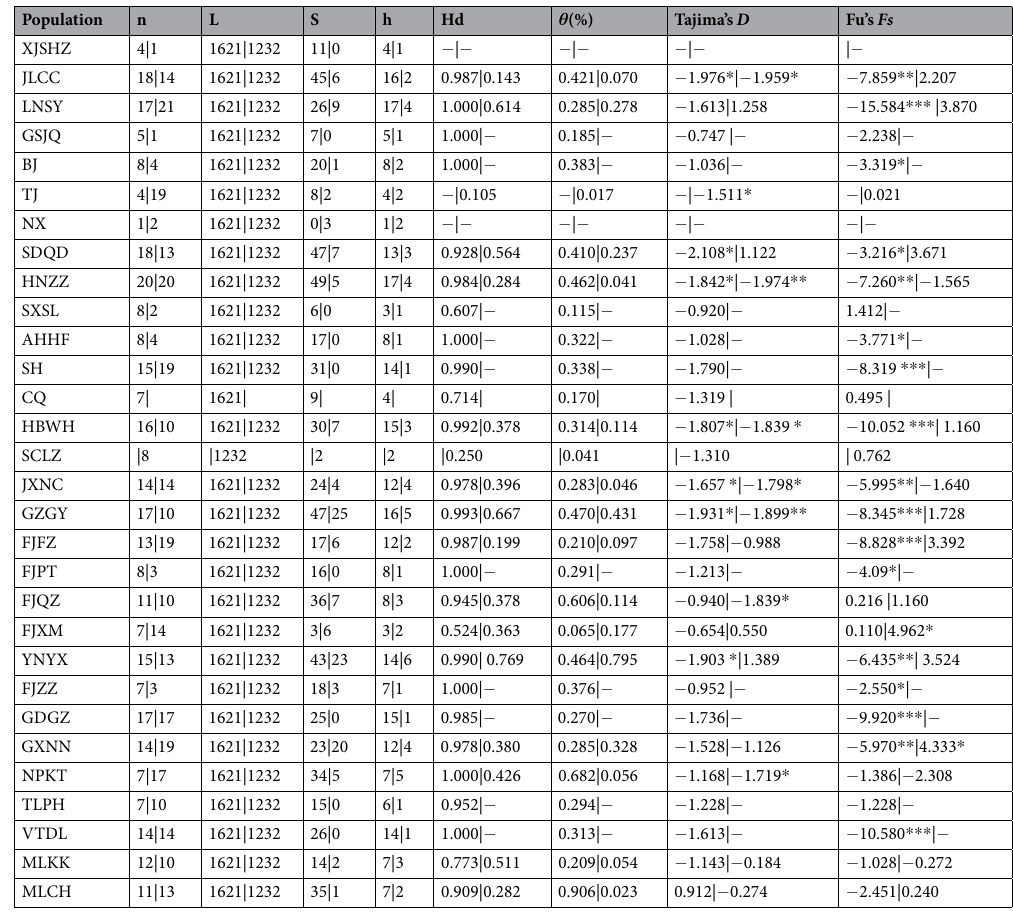
Table 1. Parameters of Genetic Diversity and Demographic History of the P. xylostella and C. vestalis Populations Based on Three Mitochondrial Genes ( CoxI , Cytb and NadhI ). Note: n represents the P. xylostella | C. vestalis sampled individuals, L is the length of DNA fragments, S is the segregating sites, h and Hd are the number and diversity of haplotypes, θ is nucleotide diversity, “ − ” denotes populations with < 5 individuals or with only one haplotype and they were not used for calculation of population parameters, “|” symbolizes the separation of P. xylostella (left) and C. vestalis (right), the significance of statistic tests are indicated by “ * ” ( P < 0.05), “ ** ” ( P < 0.01) and “ *** ” ( P < 0.001). The first 25 populations listed are from China, with the other five populations from Nepal (1), Thailand (1), Vietnam (1) and Malaysia (2). The samples within a country are listed in order from the most northerly to the most southerly latitude. Full information of the populations refers to Table